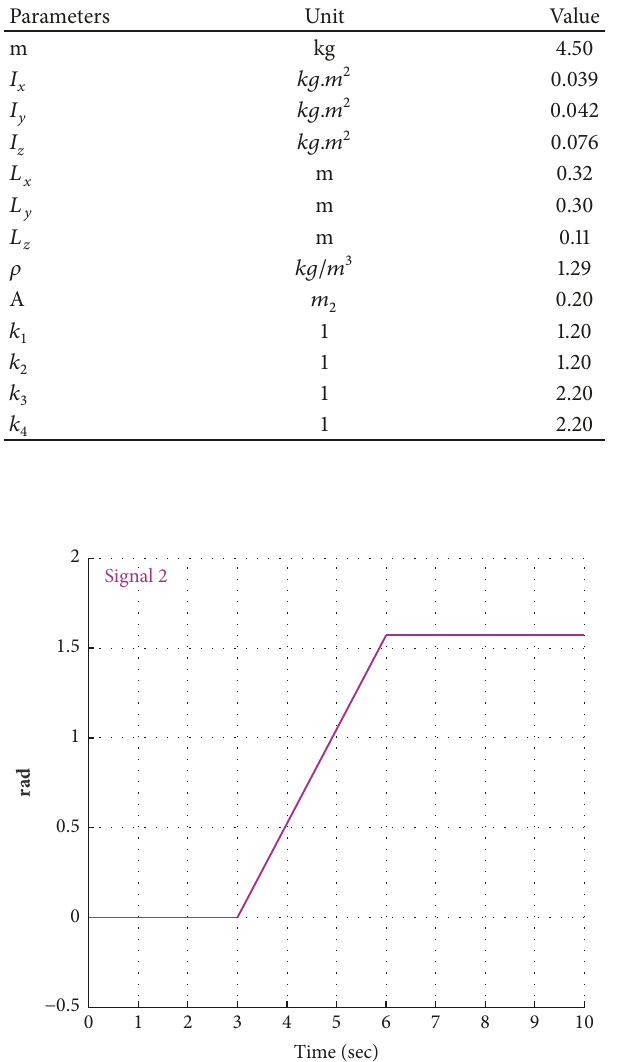
Figure 9: Tilting angle signal source.